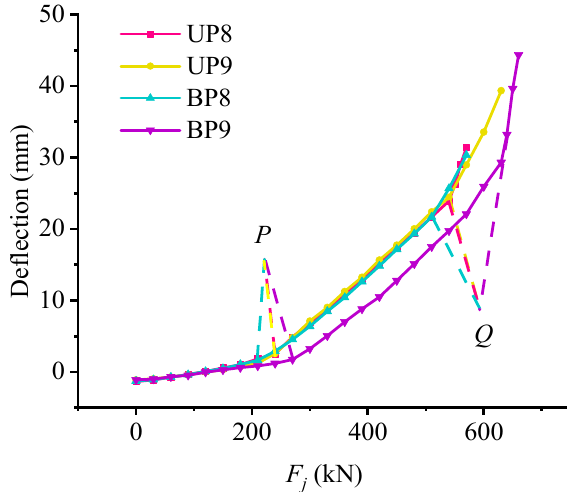
Figure 8. The influence of concrete strength on mid-span deflection (UP indicates unbonded partially prestress beam; BP indicates bonded partially prestress beam).